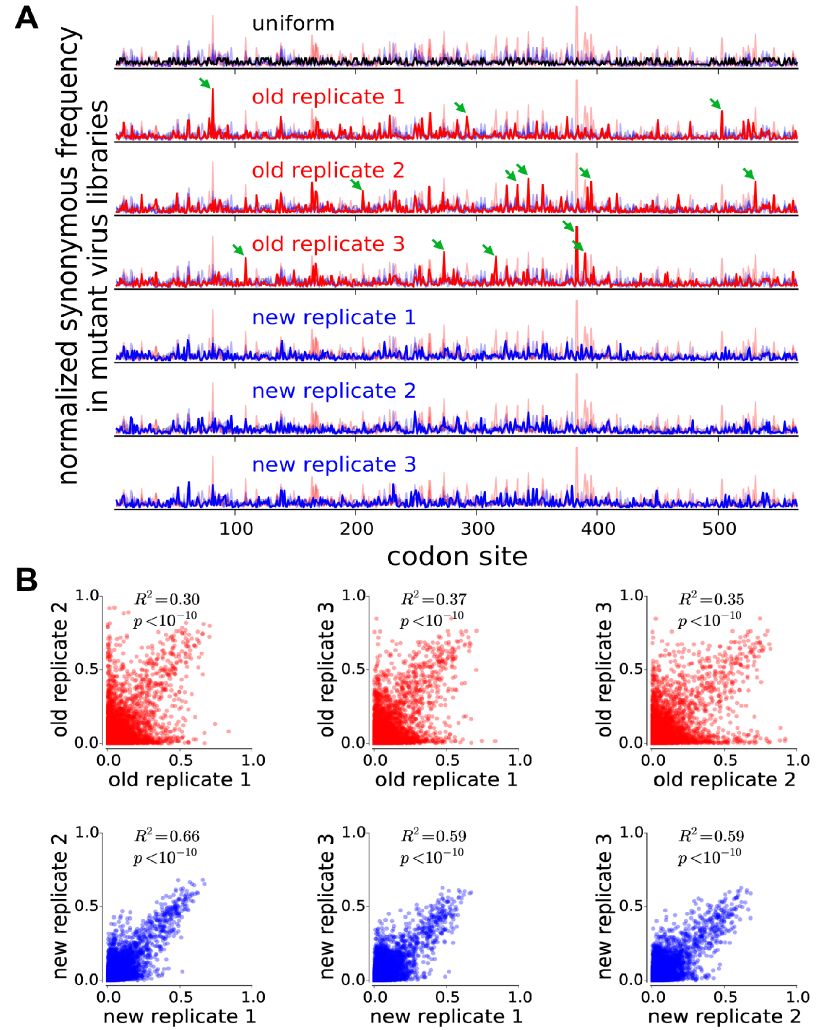
Figure 2. The use of helper viruses increases reproducibility due to reduced bottlenecking during the generation of the mutant virus libraries. ( A ) Each row shows the synonymous mutation frequency for every site normalized to the total synonymous frequency for that sample. If synonymous mutations are sampled uniformly, the data should resemble the black line in the top row (the line is not completely straight because different codons have different numbers of synonymous variants). The next six rows show the synonymous mutation frequencies for each replicate of the old ( red lines ) [4] and new ( blue lines ) experiments. To assist in comparing the locations and heights of peaks across all samples, the data for each replicate are shown as a thick line in front of thin lines representing the other five replicates. The old experiments have more bottlenecking as manifested by taller peaks indicating synonymous mutations that were stochastically enriched in each replicate (examples marked by green arrows ). The differences between replicates are not due to differences in synonymous mutation frequencies in the plasmid libraries used to generate the viruses (Figure S5). ( B ) The mutational effects measured in the new experiments are much more reproducible across replicates. Each plot shows the squared Pearson correlation coefficient for all site-specific amino-acid preferences measured in a pair of independent experimental